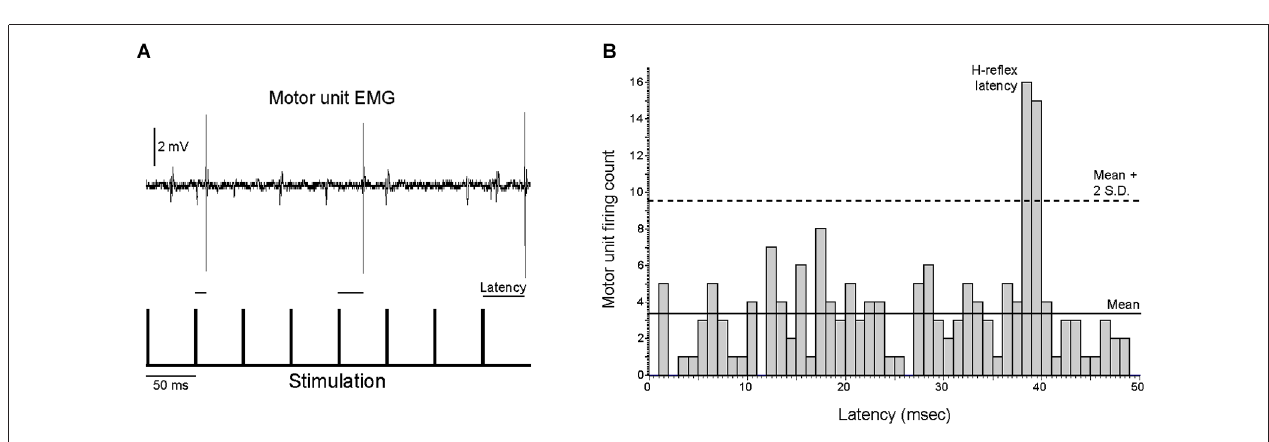
fired at an H-reflex latency more often than would be expected from random chance, as illustrated for a single motor unit that fired at an H-reflex latency 18% of the time. For all analyzed motor units, this H-reflex latency peak exceeded the mean plus two standard deviations of the number of discharges per